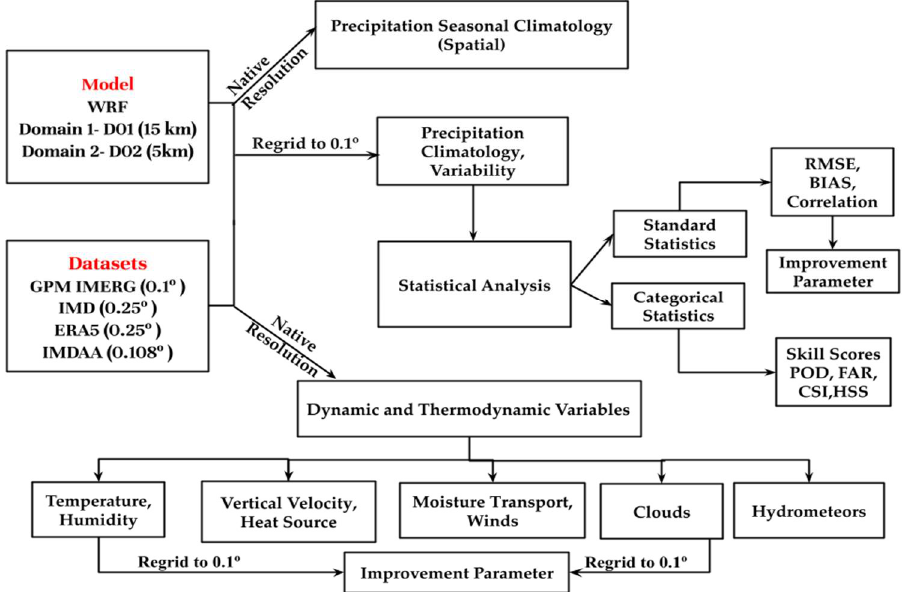
Figure 2. Flowchart of the methodology used in this study.